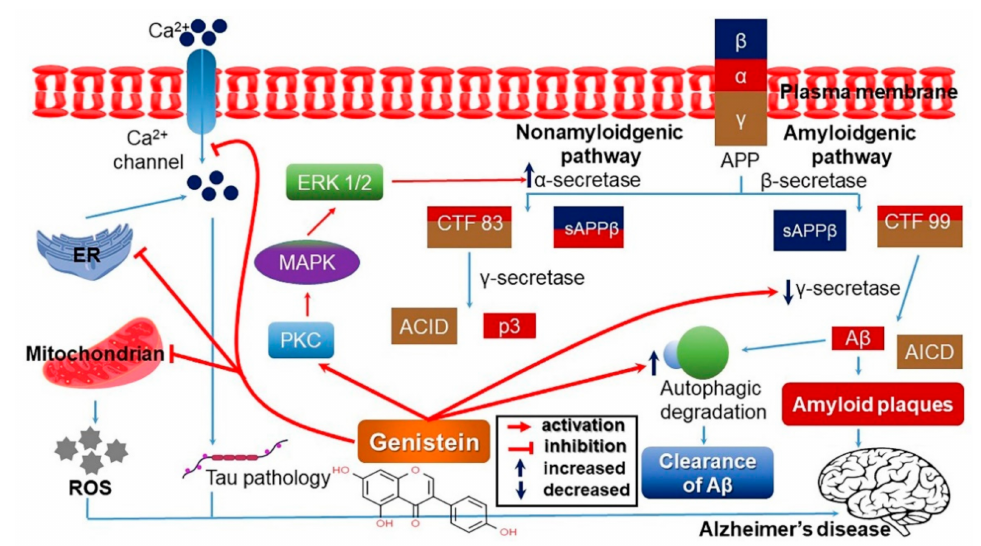
Figure 5. Proposed mechanism underlying the neuroprotective effects of genistein against neu- ropathological insults of Alzheimer’s disease. In the amyloidogenic pathway, cleavage of amyloid pre- cursor protein (APP) by β - and γ -secretases produces A β peptides, whereas in the non-amyloidogenic pathway, cleavage of APP by α - and γ -secretases provoke the formation of p3 and APP intracellular domain (AICD). Protein kinase C (PKC) signaling pathway including mitogen-activated protein kinase (MAPK) and extracellular signal-regulated kinase 1 and 2 (ERK1/2), activated by genis- tein, activates the non-amyloidogenic pathway of APP cleavage by increasing α -secretase activity. In the amyloidogenic pathway, genistein inhibits the formation of A β peptides by decreasing γ - secretase. Further, genistein reduces Tau-mediated pathology by decreasing intracellular calcium concentrations, inhibiting oxidative stress-mediated neuronal damage and death by inhibiting the reactive oxygen species (ROS) released from mitochondria and promoting autophagic clearance of aggregate-prone proteins [57]. Figure adapted from Uddin and Kabir